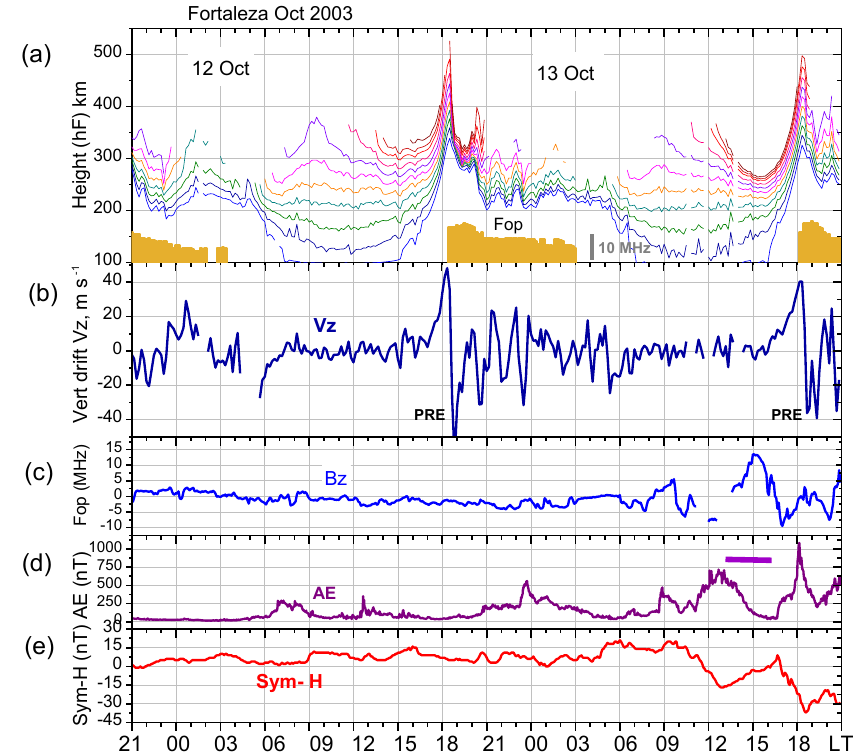
Figure 4. Variations during 12–13 October 2003 in the ionospheric parameters over Fortaleza and magnetic field/indices variations in panels from top to bottom: (a) F layer heights at fixed plasma frequencies, from 3 to 13MHz, and Spread F index fop, the top frequency of the spread F trace in the ionogram in MHz with scale shown inset; (b) Vertical drift as mean of the drifts calculated at 4, 5, 6 and 7MHz; (c) the interplanetary magnetic field component B z ; (d) Auroral electrojet activity index AE; (e) The Sym-H representing 1min Dst values.